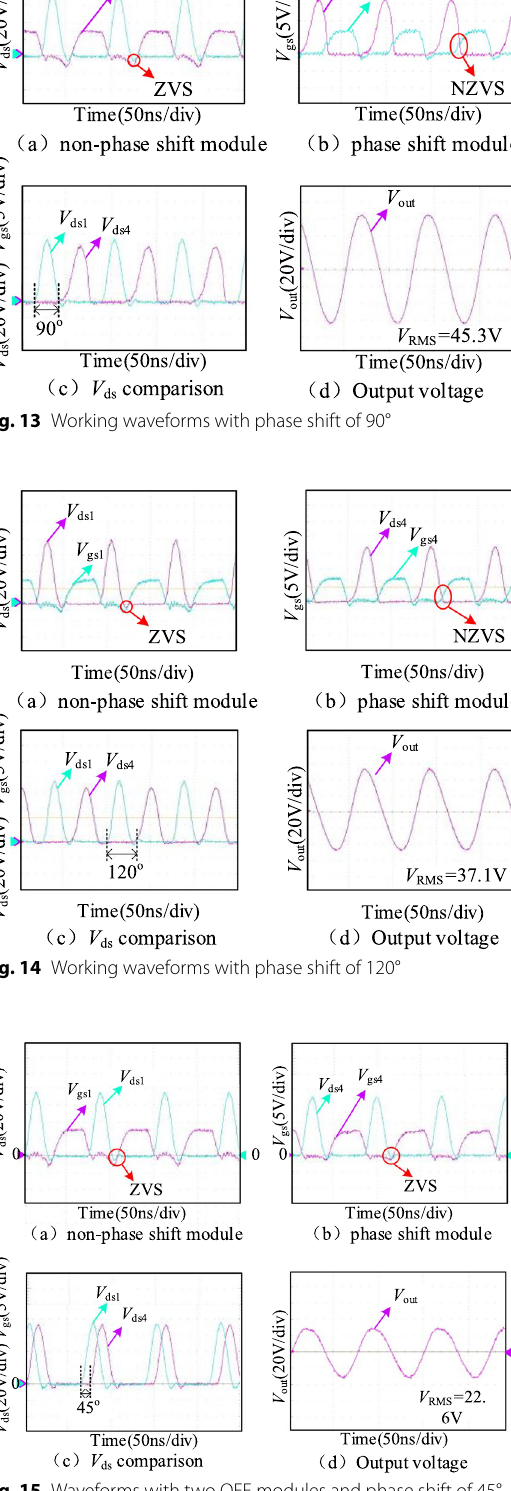
Fig. 15 Waveforms with two OFF modules and phase shift of